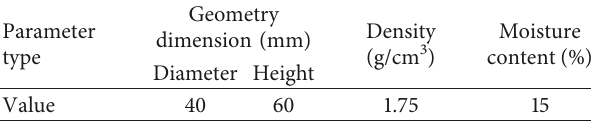
Table 1: Physical parameters of rare earth ore